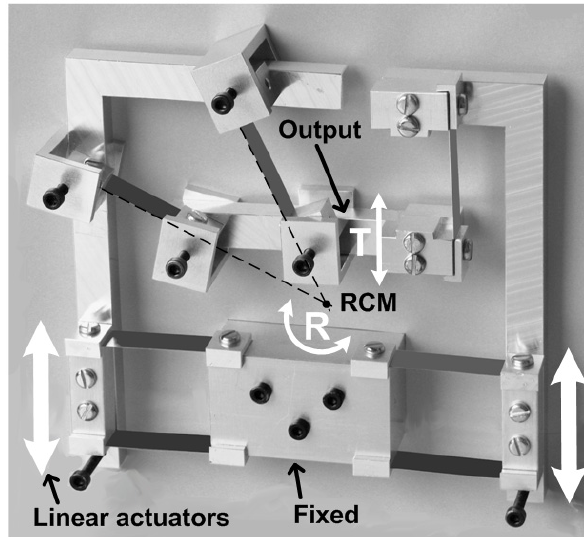
Figure 5. Mock-up of the designed active T k R ⊥ brick